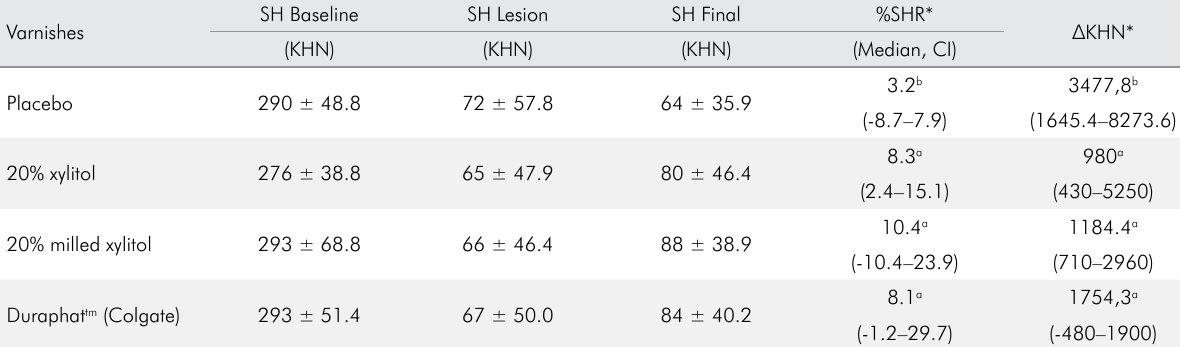
Table 2. Surface hardness measurements at baseline (SH baseline), after demineralization (surface hardness loss - %SHL), after treatment and pH cycling (SH final), percentage of surface hardness recovery (%SHR) and integrated mineral loss (ΔKHN) for the permanent teeth in vitro (n =